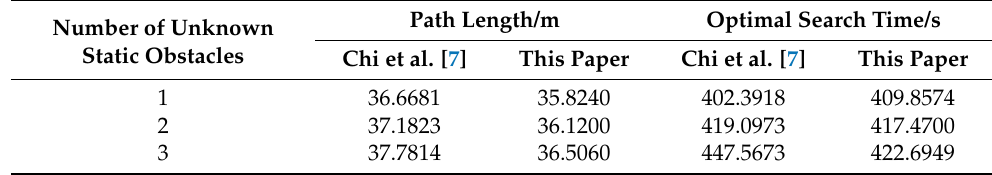
Figure 20. Comparison of path planning results for unknown static environment 3; ( a ) Local path planning [7] ( b ) This paper; and ( c ) Line speed comparison diagram. Table 6. IACO- IDWA path planning performance